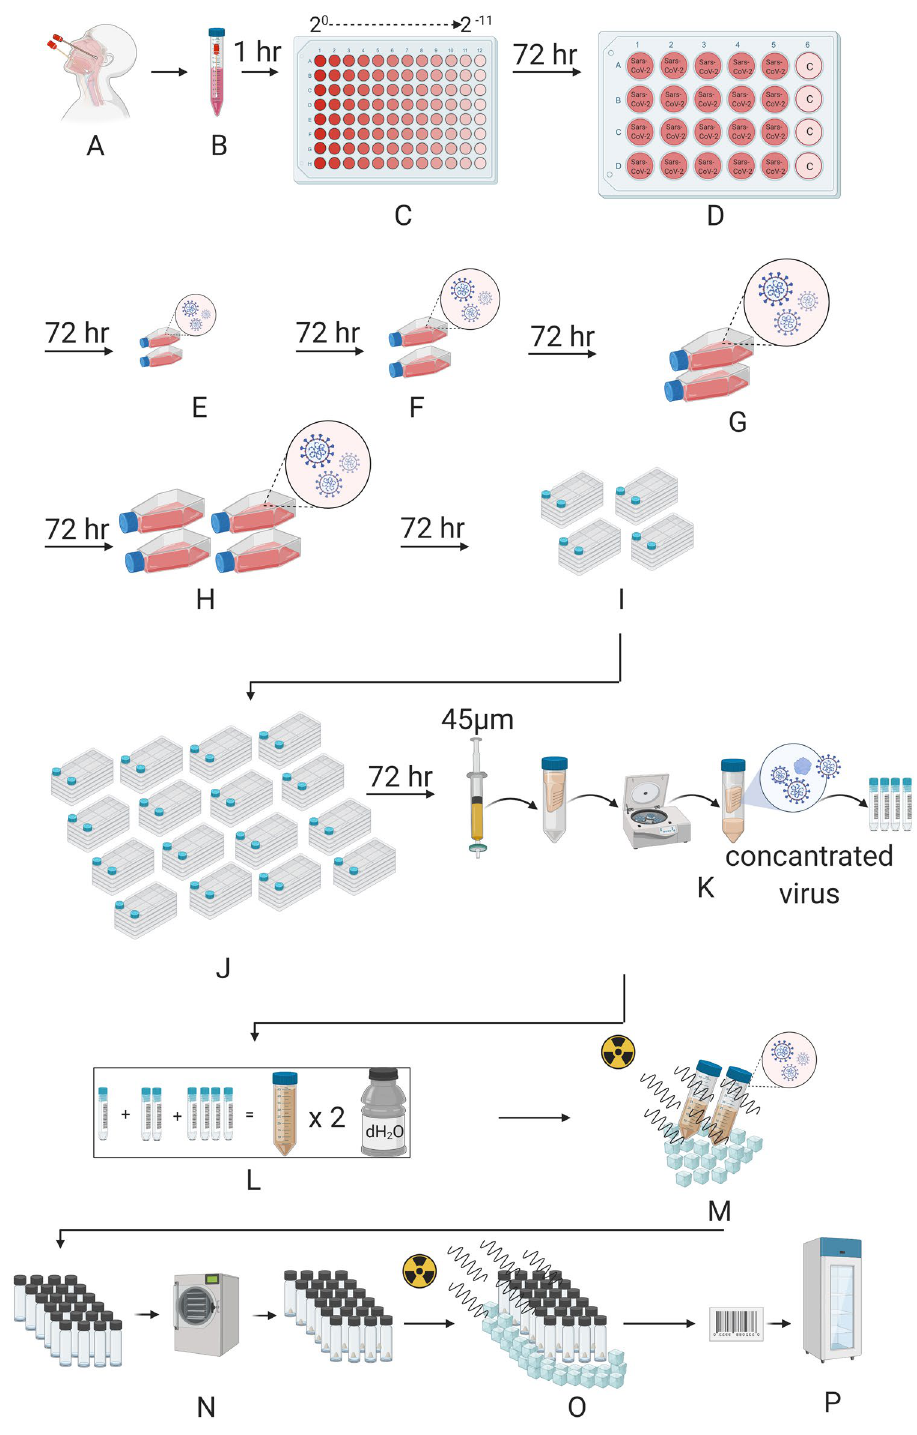
Figure 1. Representation of Gamma-irradiated inactive lyophilized SARS-CoV-2 manufacturing. ( A ) Nasopharyngeal and Oropharyngeal samples were taken. ( B ) Sample came to the laboratory in a 2–8 C transfer solution. ( C ) The virus was distributed by making serial dilution (up to 2 −11 ) onto Vero cells. Viruses were transferred to ( D ) a 24-well plate ( E ) T-75 flasks F. T-175 flasks ( G ) and ( H) T-300 flasks with a confluent with Vero cells by increasing culturing surface area. Next, the propagated virus was transferred to ( I ) four and ( J ) sixteen multi-layered flasks with a confluent with Vero cells. ( K ) The total virus solution was then passed through a 45 µm filter, the virus was concentrated by centrifugation in a special tube with a 100 KDa filter. The concentrated virus was stored at -80 °C before irradiation. ( L ) All concentrated viruses obtained are pooled and washed two times with distilled water for diafiltration in a 100 KDa concentrator. ( M ) The concentrated virus mixture was inactivated by irradiation at 25 kGy in dry ice. ( N ) Inactivated virus is lyophilized after dose adjustment. ( O ) The lyophilized virus mixture is sterilized by irradiation at 25 kGy in dry ice. ( P ) The lyophilized bottled inactive SARS-CoV-2 vaccine is labeled and stored at 4